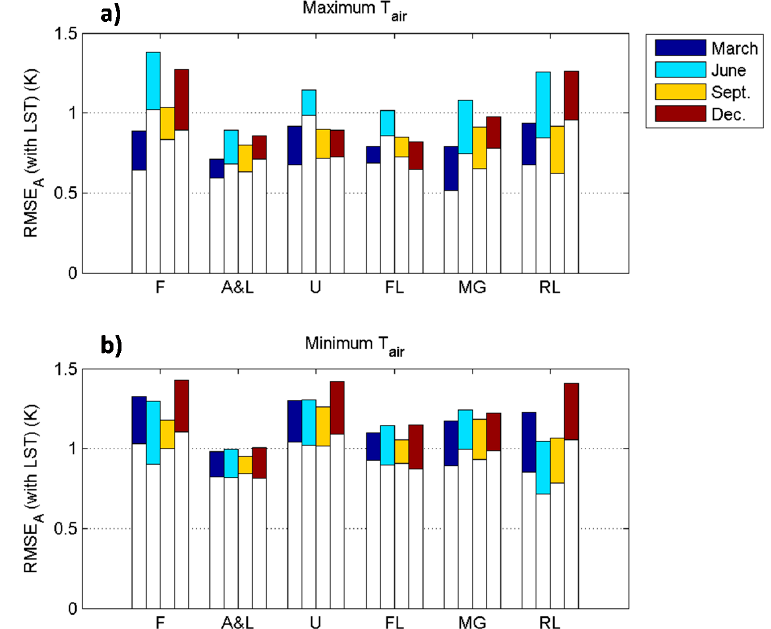
Figure 4. Minimum (white bars) and mean (colored bars) RMSE A of maximum ( a ) and minimum ( b ) T air obtained by considering models including the LST product providing the best estimates (in terms of RMSE A ). Results from regressions for the years 2003–2015 and the following sets of meteorological stations: F: Forests ; A&L: Agricultural and livestock ; U: Urban areas ; FL: Flat lands ; MG: Middle grounds ; RL: Rugged lands .